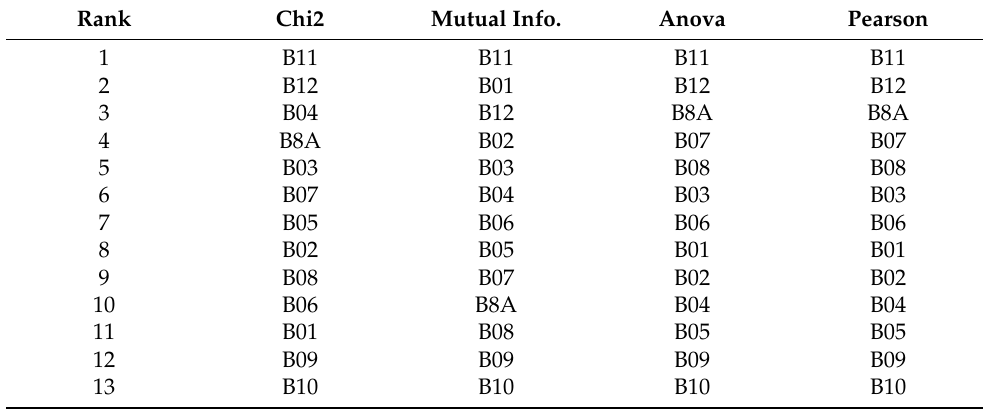
Table 5. Feature Analysis: Feature Ranking using Statistical Algorithms. Rank Chi2 Mutual